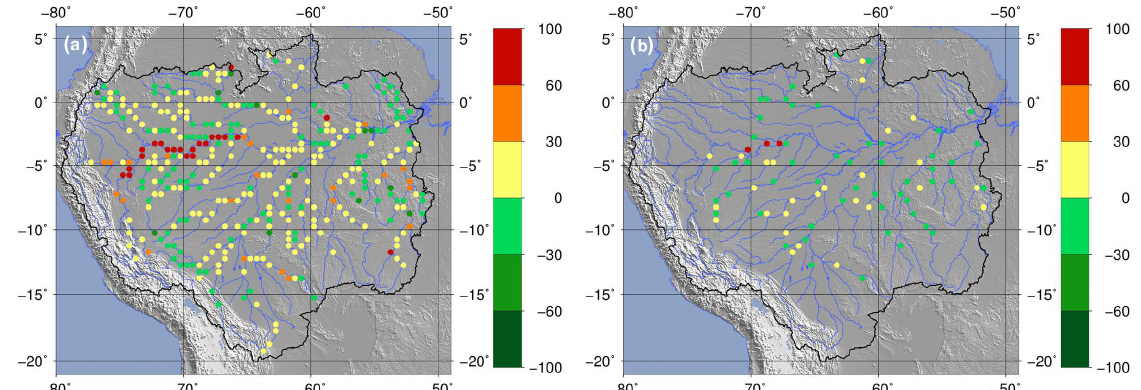
Figure 12. Analysis RMSEn differences between SE1-local and SE2-local experiments with respect to (a) the ENVISAT discharge and (b) gauge discharge.